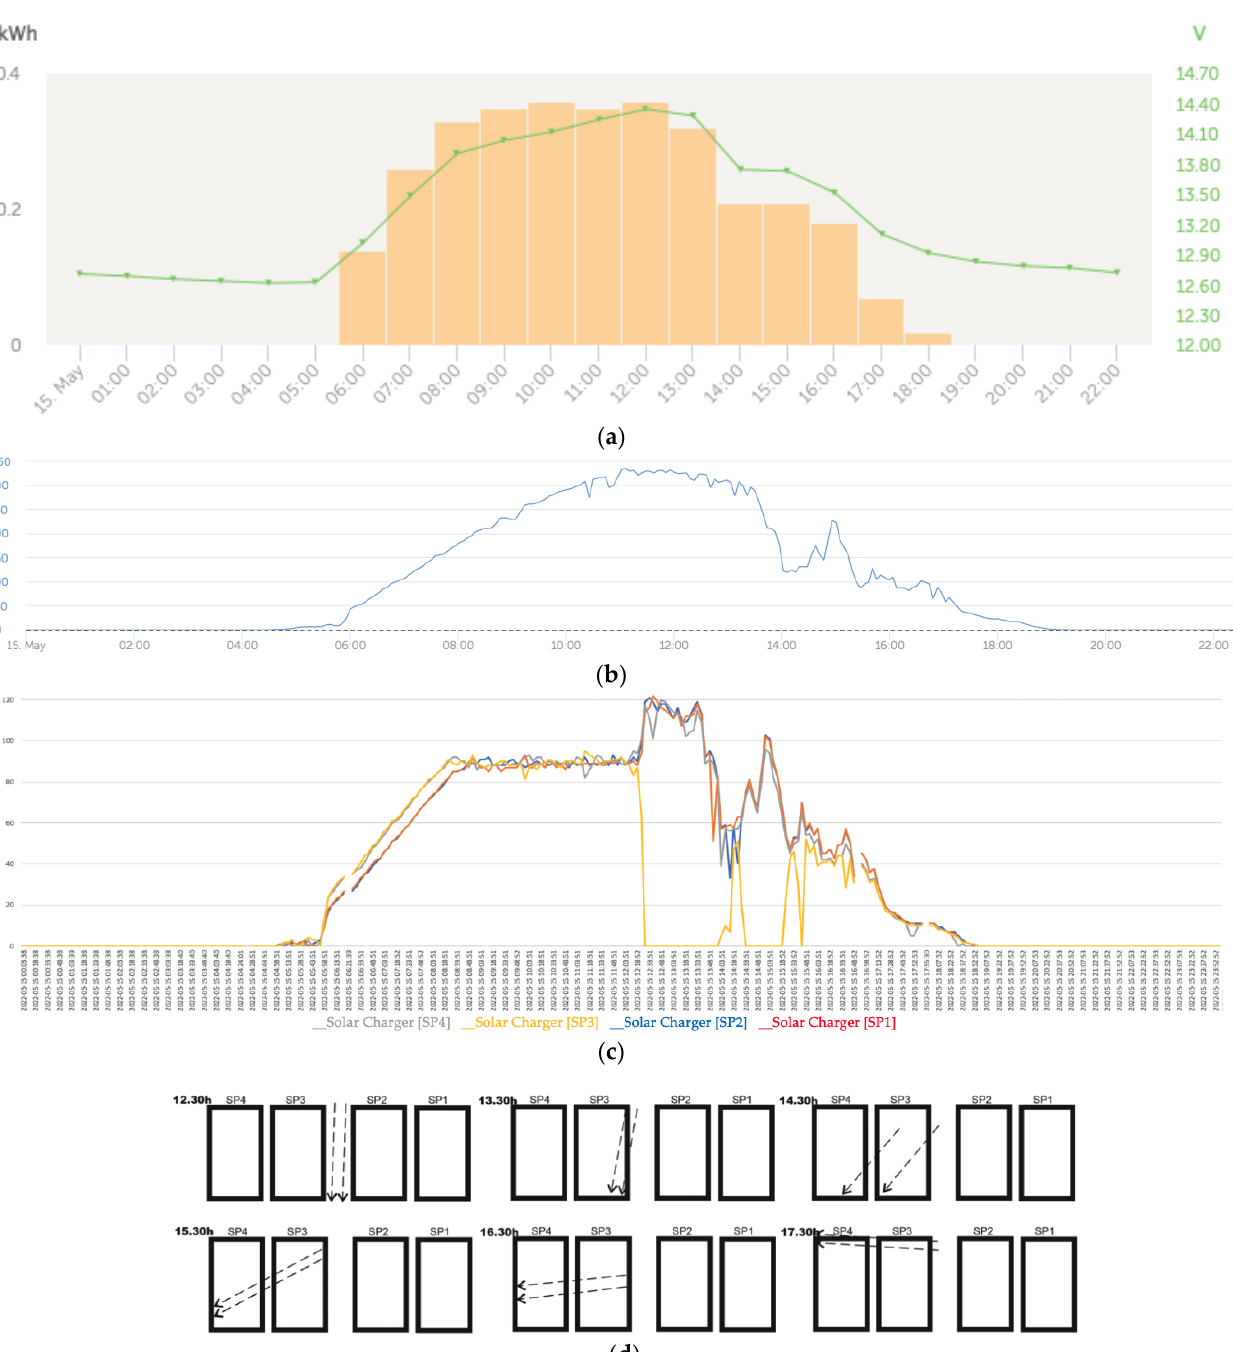
Figure 23. ( a ) Daily charge phases: initial, absorption, and flotation (15 May). ( b ) Irradiance (15 May). ( c ) Deviation Trend Comparative PV Power Data Series Analysis (15 May). ( d ) Daily partial shading displacement by the hour.